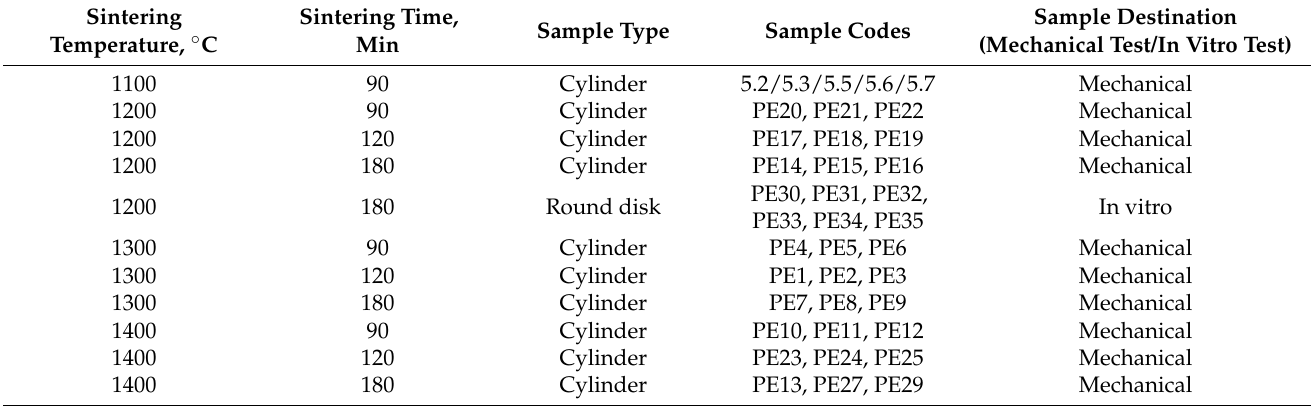
Table 1. Sintering conditions and type of sintered for HAp